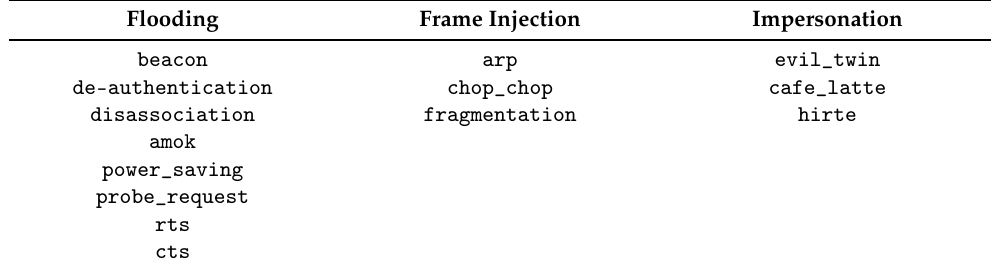
Table 1. Distribution of the 14 attack classes within the three attack macro-classes. Flooding Frame Injection Impersonation beacon arp evil_twin de-authentication chop_chop cafe_latte disassociation fragmentation hirte